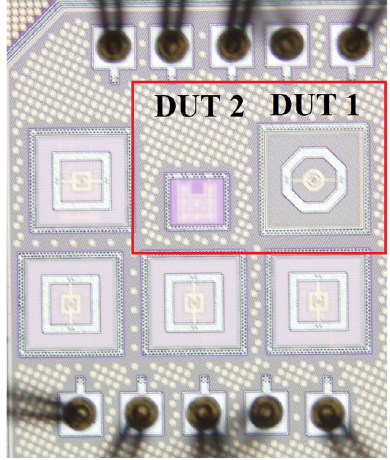
Figure 5. Die micrograph of thermal detectors.